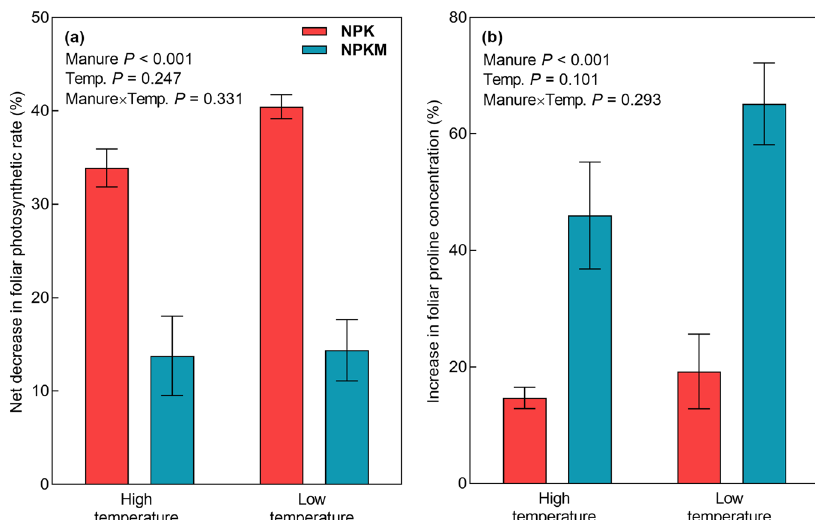
Fig. 3 Effect of temperature stress with and without manure amendment on net foliar photosynthetic rate and foliar proline concentration in a pot experiment. a Effect of temperature stress net foliar photosynthetic rate ( n = 4). b Effect of temperature stress on foliar proline concentration ( n = 4). NPK, inorganic fertilizer; NPKM, a combination of manure and inorganic fertilizer. Error bars represent standard errors (SE). Table 1 Effect of manure amendment on soil properties in a long-term fi eld